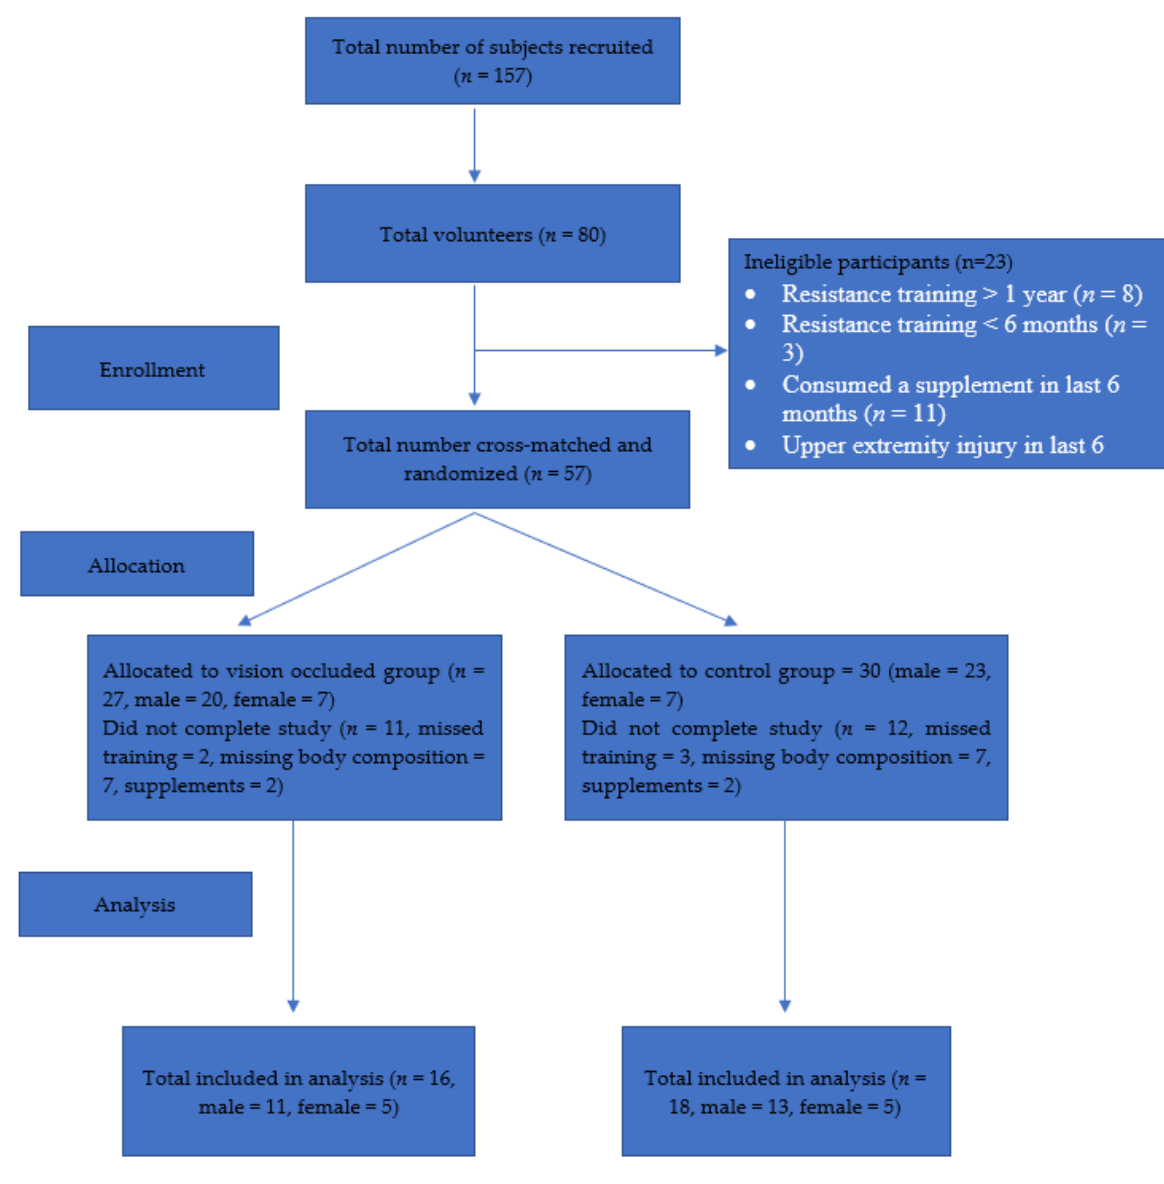
Figure 1. CONSORT flow diagram.